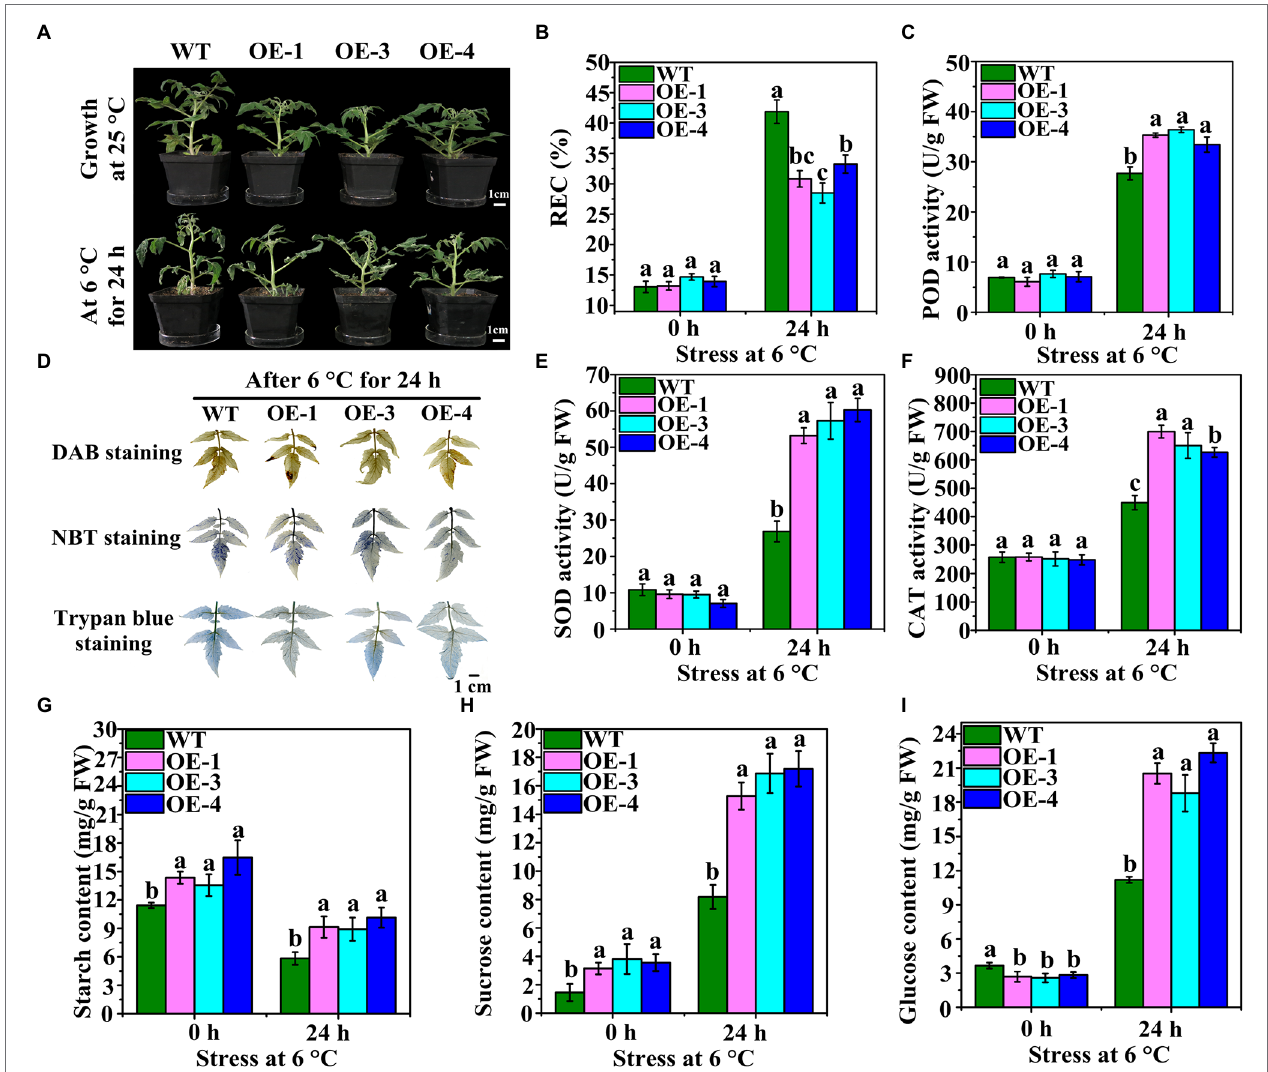
FIGURE 5 | Phenotypes and antioxidant enzymes of OEs under LT treatment. (A) Phenotypes of OEs (OE-1, OE-3, and OE-4) and wild-type (WT) at 25 ° C and under LT stress at 6 ° C after 24 h. (B) DAB, NBT, and trypan blue staining of WT and OE leaves at 6 ° C for 24 h. (C) REC change in WT and OEs were subjected to LT treatment at 6 ° C for 0 h and 24 h. (D – F) The changes in POD, SOD, and CAT activities in WT and OEs subjected to LT stress at 6 ° C after 0 h and 24 h. (G – I) The changes in starch, sucrose, and glucose contents in WT and OEs subjected to LT stress at 6 ° C after 0 h and 24